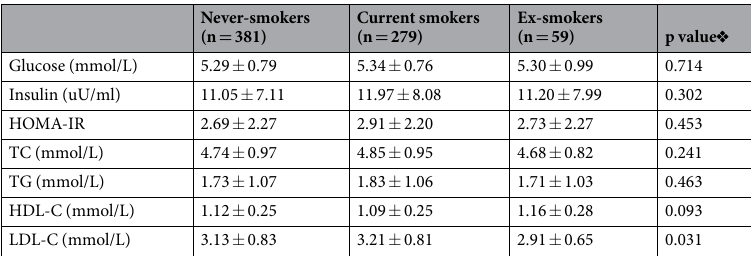
Table 6. Metabolic variables of OSAS subjects with different smoking status. Abbreviations: HOMA-IR, homeostasis model of assessment for insulin resistence index; OSAS, obstructive sleep apnea syndrome; TC, total cholesterol; TG, triglyceride; HDL-C, high density lipoprotein cholesterol; LDL-C, low density lipoprotein cholesterol. p value indicates overall